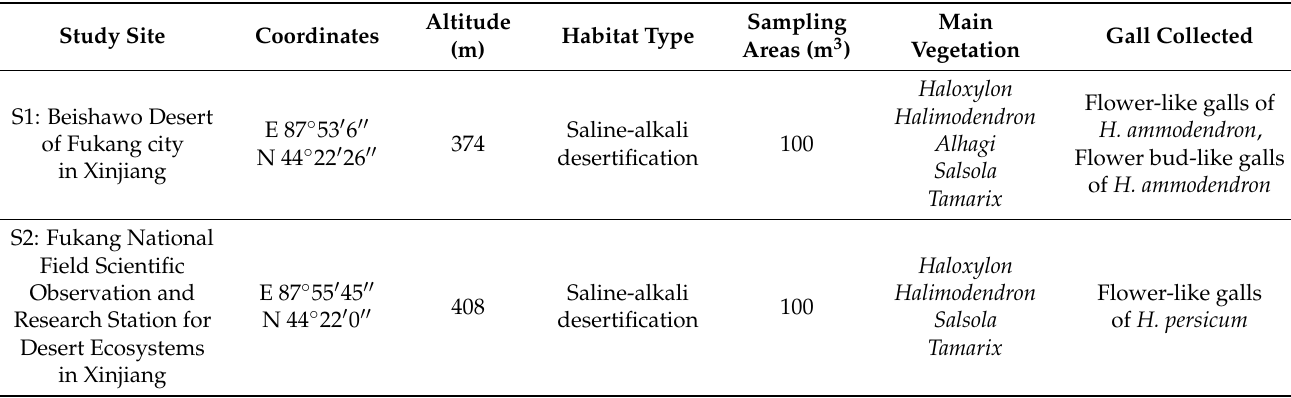
Table 1. Survey sites of Haloxylon in Fukang in